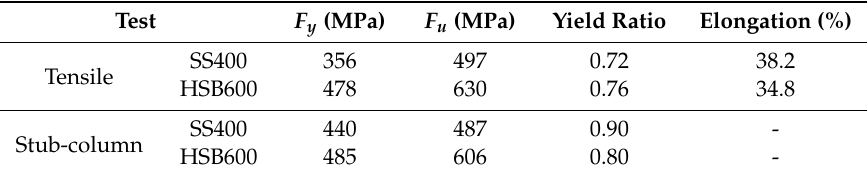
Table 3. Results of material properties.